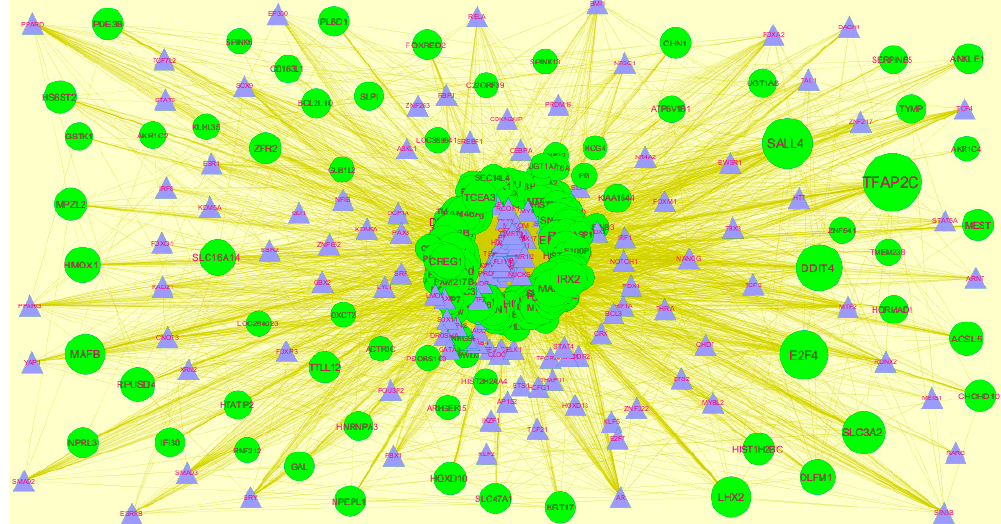
Figure 14. TF- gene network of predicted target up-regulated genes. Blue triangles are TFs and green circles are target up-regulated genes. Yellow lines means interaction with adjutant genes or TFs.